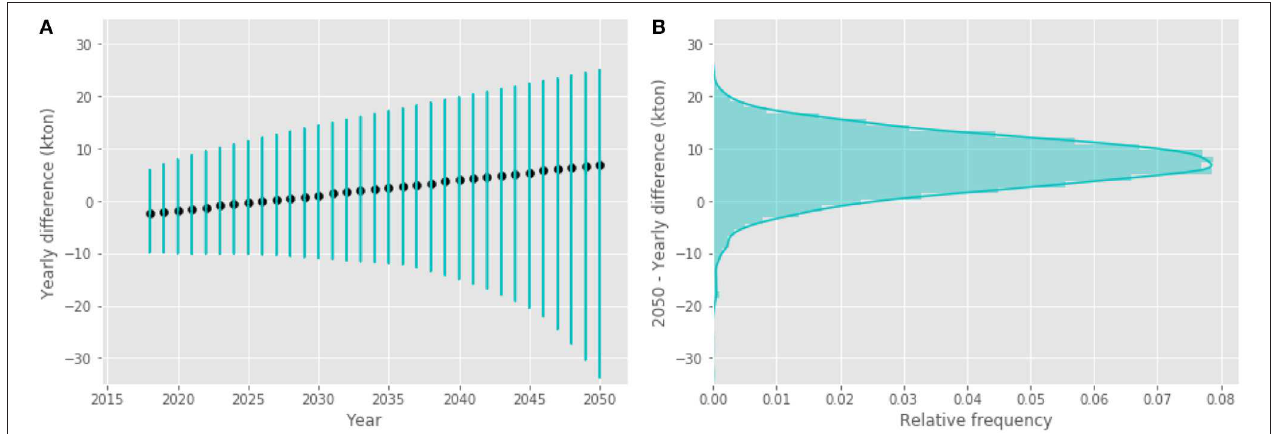
FIGURE 4 | (A) Yearly difference between the extrapolated extraction capacity and 80% of the projected yearly demands (20% has been assumed to be met by scrap recycling) over 2018–2050. Negative values correspond to a deficit (demand higher than extraction capacity). Monte Carlo analysis simulations run on 8,192 quasi-random samples. The means of the yearly distributions are shown in black. (B) The distribution of the simulation outcomes for the year 2050 (yearly silver difference against relative